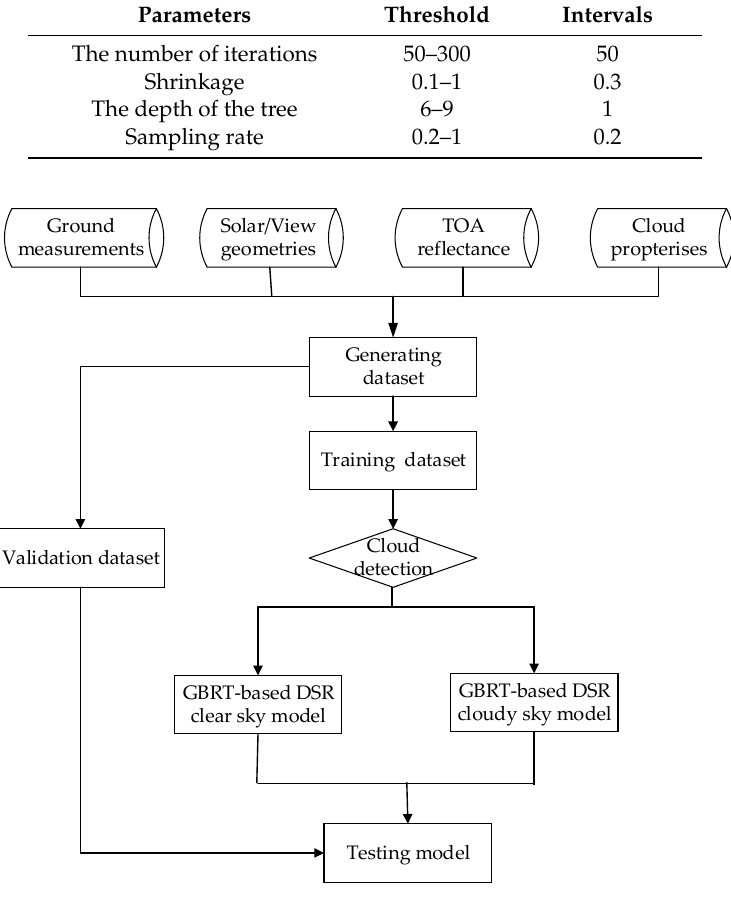
Figure 3. Flowchart of the GBRT method.